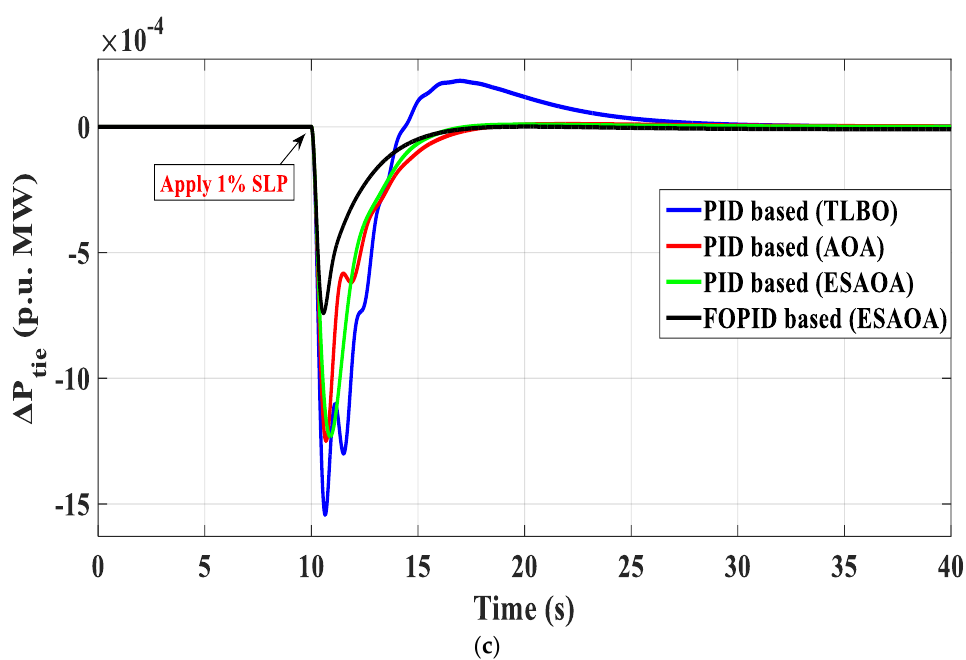
Figure 15. Dynamic system response of scenario A considering 1% SLP at the first area ( a ) ∆ f 1 , ( b ) ∆ f 2 , and ( c ) ∆ p tie .